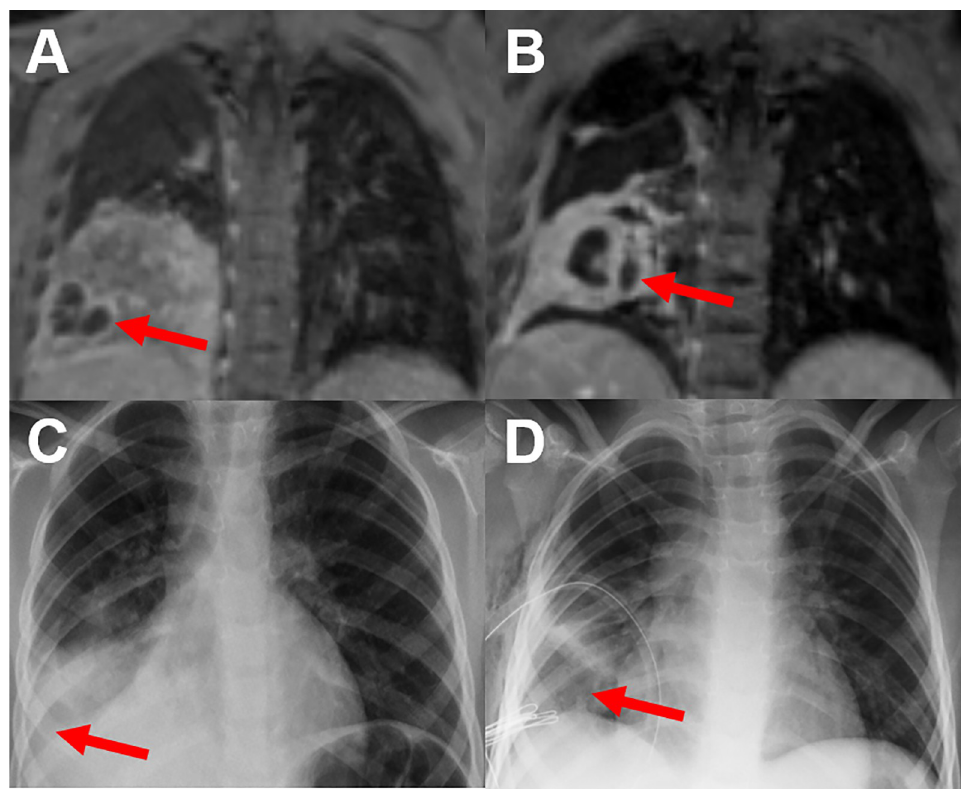
Fig 5. Comparison of T2-weighted sequences and CXR of an 11-year-old child at baseline and follow-up. MRI shows an abscess formation in the right lower lobe at baseline (red arrow) (A). The surrounding inflammatory changes regressed under therapy, whereas the abscess formation increased at follow-up (red arrow) (B). The abscess formation was not detected by CXR (red arrows) (C+D). Furthermore, the extension of pathologic findings was underestimated by CXR (D).